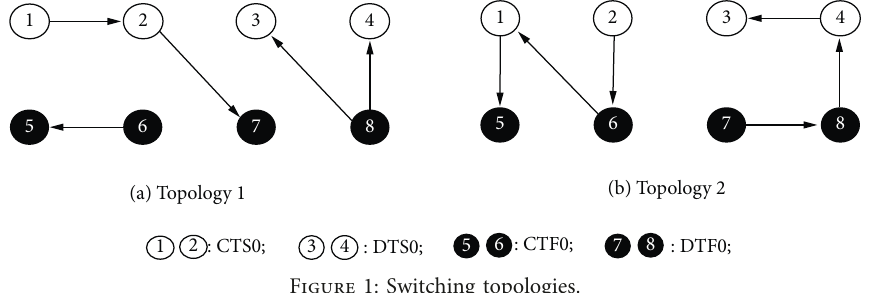
Figure 1: Switching topologies.